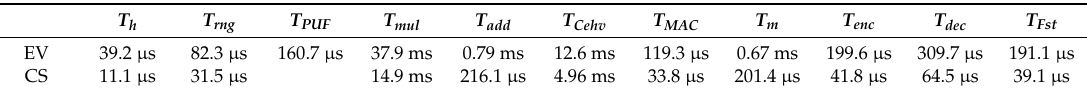
Core ™ i7 for electric vehicles (EV) and charge stations (CS), respectively.